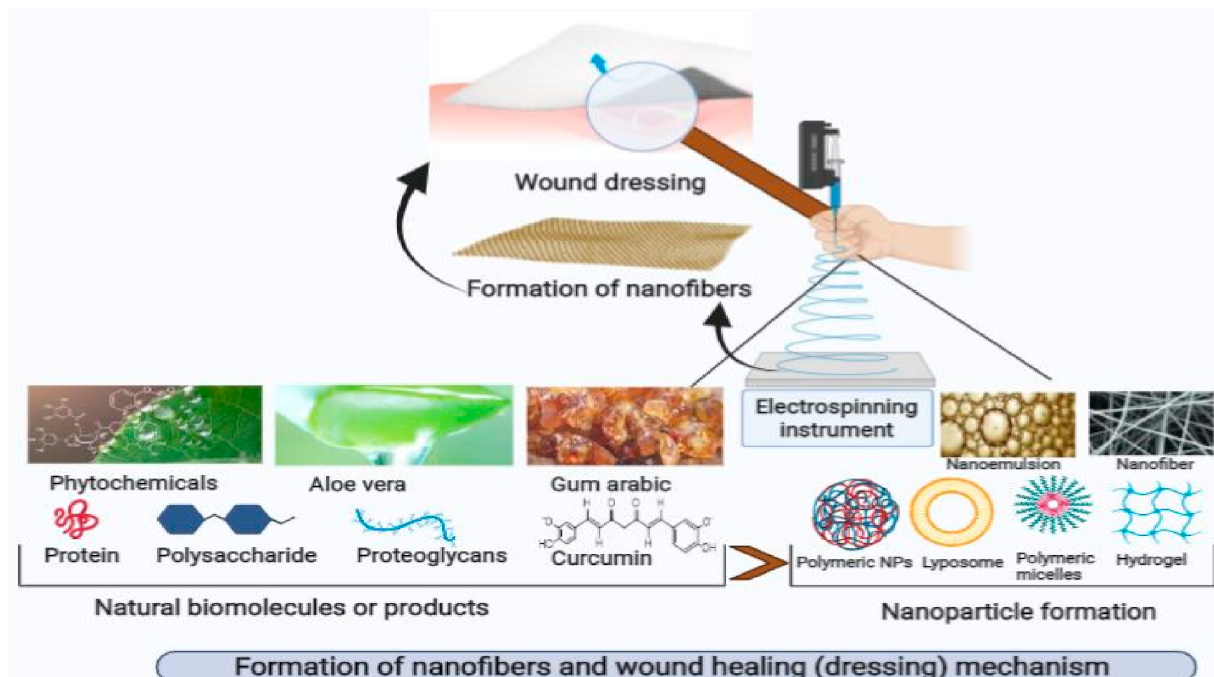
Figure 4. Schematic illustration of nanofiber formation and their role in wound